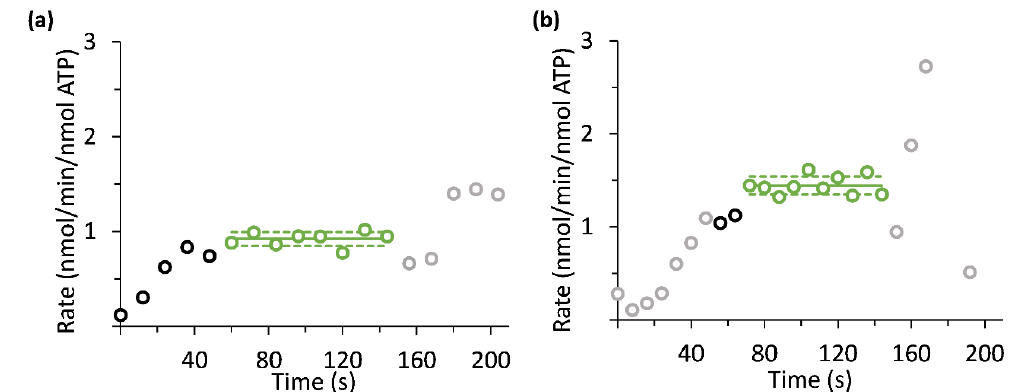
Figure 7. [1- 13 C]lactate production rates per ATP content as determined in live tumor slices using selective excitations in a perfusion arrest and a continuous perfusion experimental designs. One experiment from each experimental design is shown. (a) [1- 13 C]lactate production rate as determined in a perfusion arrest system. (b) [1- 13 C]lactate production rate as determined in a continuous perfusion system. The dissolution medium was injected at about 27 °C and 37 °C, in (a) and (b), respectively. The points marked in green and black represent data that were acquired under the condition of constant [1- 13 C]pyruvate concentration. The mean and standard deviation interval of the [1- 13 C]lactate production maximal rate are marked by solid and dashed green lines, respectively. The points in light grey correspond to measurements recorded at a non-constant and therefore unknown concentration of [1- 13 C]pyruvate. Since the amount of [1- 13 C]pyruvate is not known for these points (as they are either in the wash in or in the wash out phase), the rates of production were not quantified at these times. The points in black correspond to measurements recorded at a constant known concentration of [1- 13 C]pyruvate, but before the [1- 13 C]lactate production rate stabilized.